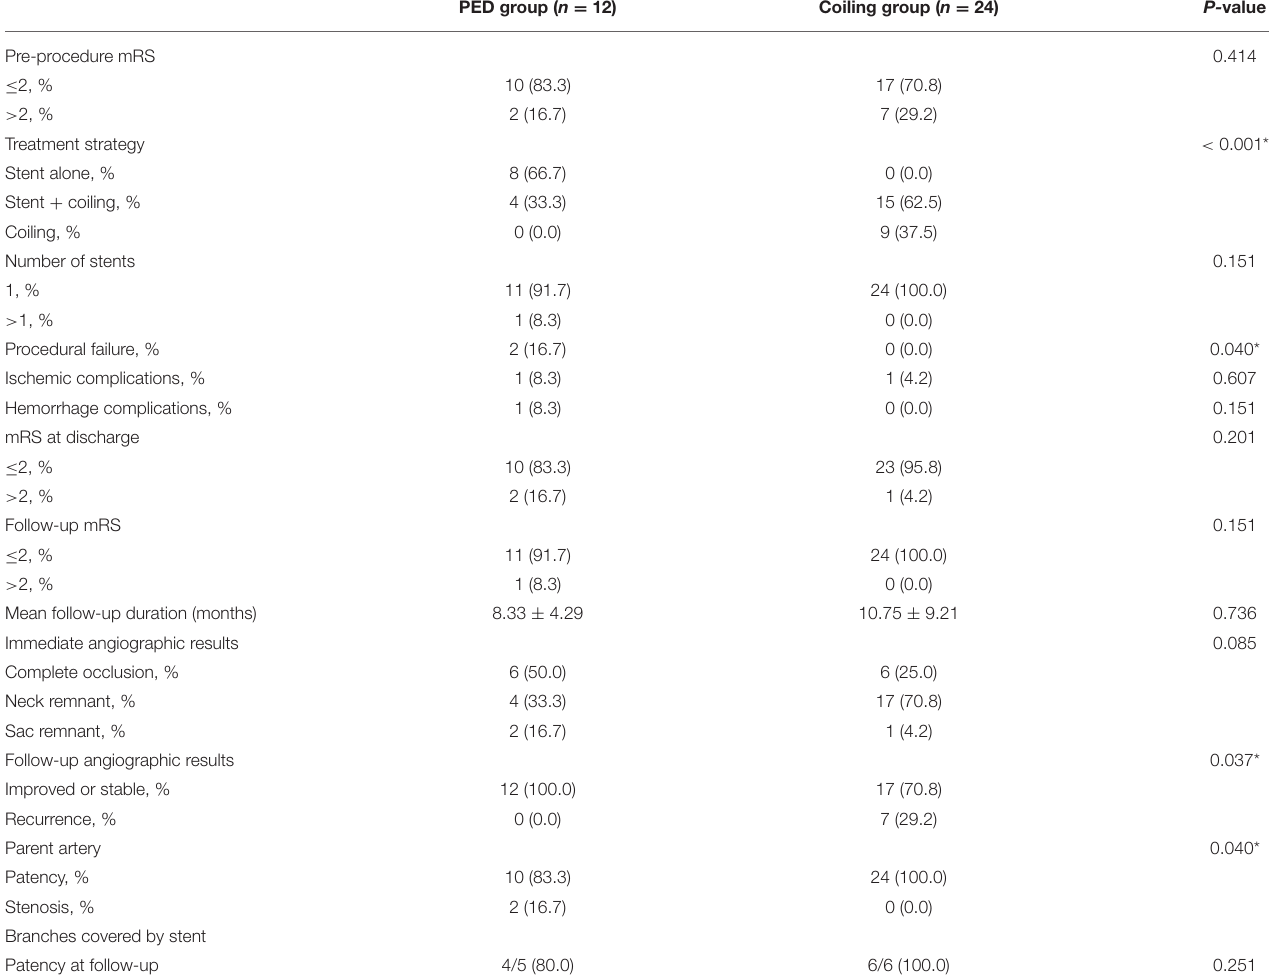
TABLE 2 | Treatment, complications, angiographic, and follow-up results of the recurrent aneurysm after 1:2 matching by propensity score. PED group ( n = 12) Coiling group ( n = 24) P-